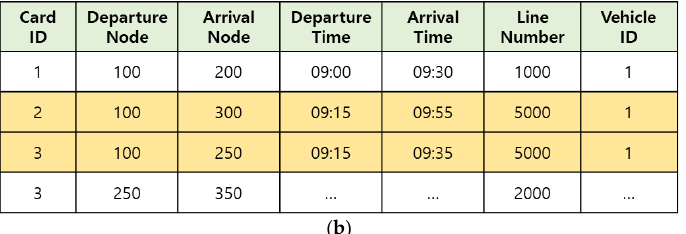
Figure 5. Map of route of bus No. 1167.